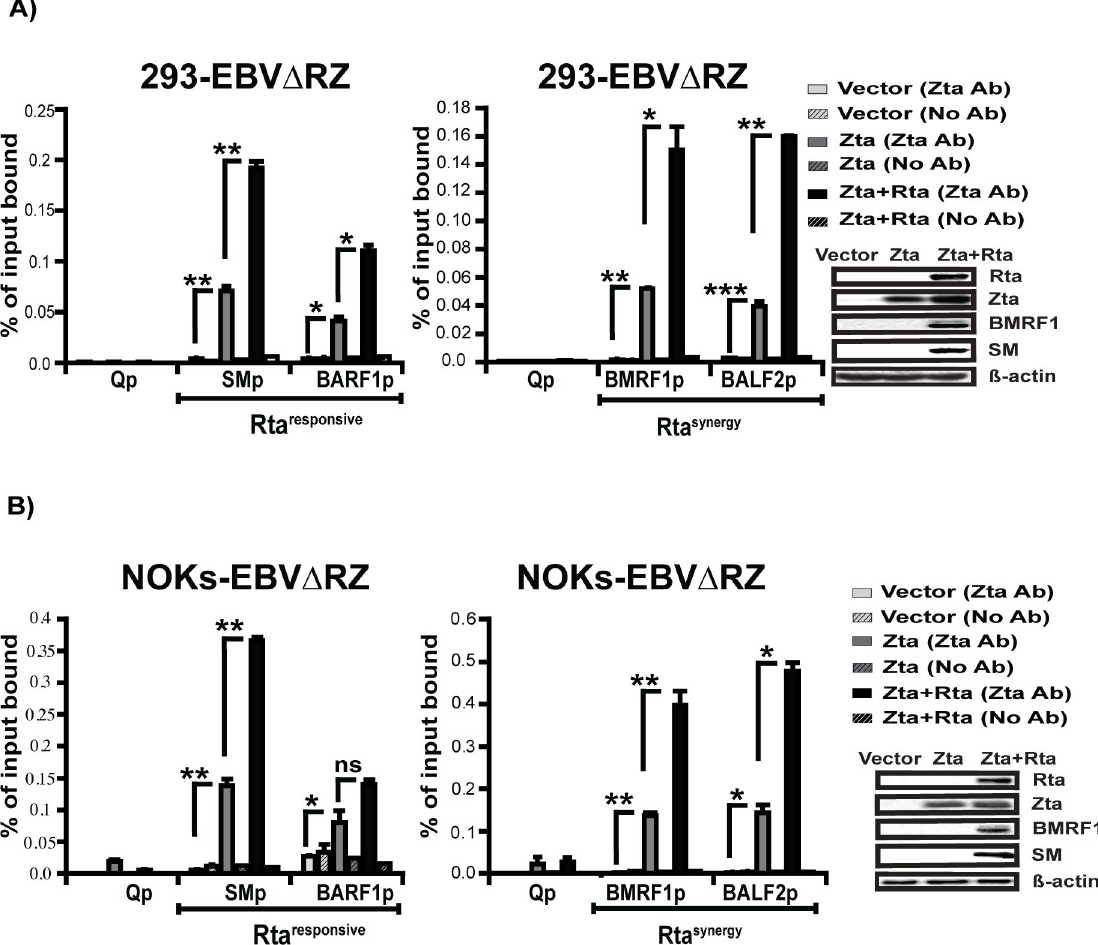
Fig 7. Rta increases Zta binding at Rta responsive and Rta synergy gene promoters. Chromatin immunoprecipitation and quantitative PCR (ChIP-qPCR) data for (A) 293-EBV Δ RZ or (B) NOKs-EBV Δ RZ showing Rta association with control (Qp), Rta responsive (SMp and BARF1p) and Rta synergy (BMRF1p and BALF2p) promoters. Cross-linked chromatin prepared from cells were trans-complemented with vector, Zta, or Zta and Rta as indicated. Cross-linked chromatin was immunoprecipitated with anti-Zta antibody (Zta Ab) or left untreated (No Ab) and quantified relative to input DNA. For each chromatin prep, western blots were performed (far right panels) to ensure early gene induction (BMRF1 and SM) and that equivalent amounts of Zta were expressed in the Zta and Zta+Rta conditions. Data shown in (A) are representative of two independent experiments and the NOKs ChIP (B) was performed once. Error bars indicate standard error of the mean and significant differences are indicated as follows: P � 0.05 ( � ), P � 0.01 ( �� ), P � 0.001 ( ��� ), P > 0.05 (ns).